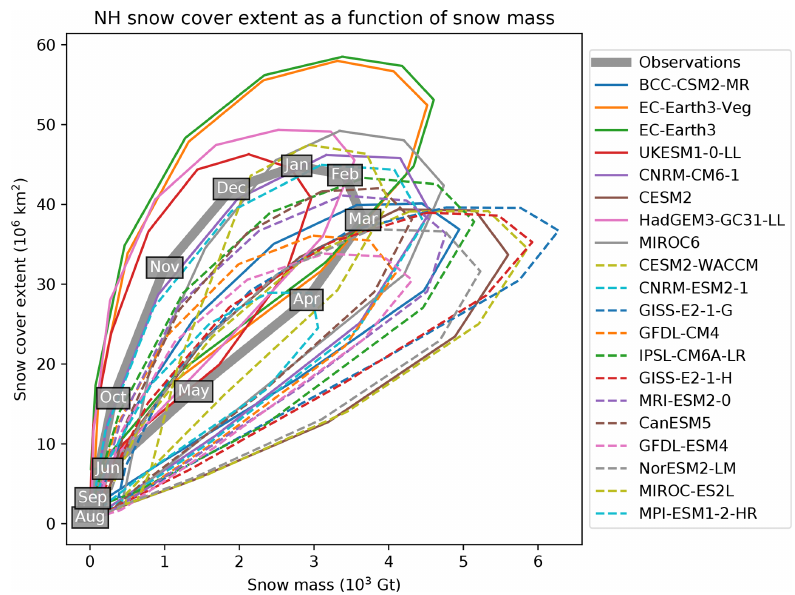
Figure 11. Relationship between the 1981–2014 monthly mean hemispheric snow cover extent and monthly mean total hemispheric snow mass in the observation-based ensemble mean and the CMIP6 models. Summer months are located near (0 / 0) and data run clockwise through the annual cycle; that is, autumn is on the upper branch and spring is on the lower branch of the